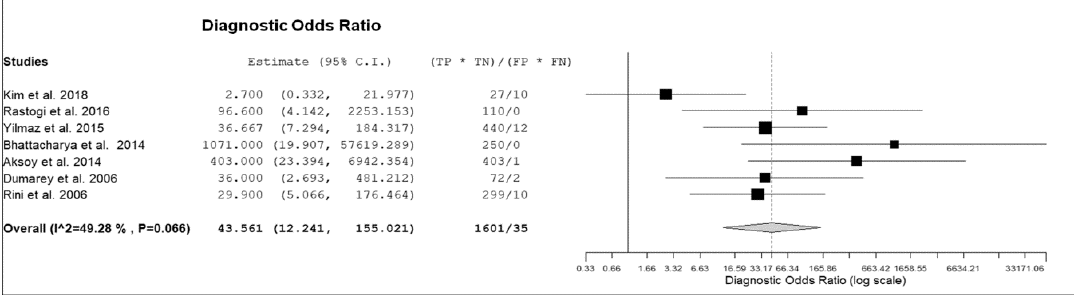
Figure 5. Forest plot of individual studies and pooled diagnostic odds ratio of 18 F-FDG-WBC PET or PET/CT in patients with suspicious infectious diseases, including 95% confidence interval (95%CI). The size of the squares indicates the weight of each study.